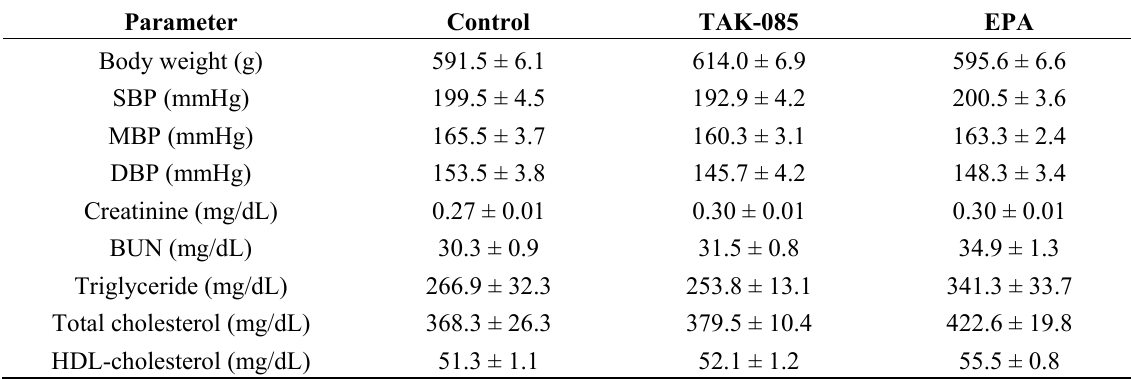
Table 1. Effects of TAK-085 and EPA administration on body weight, blood pressure, and plasma biological